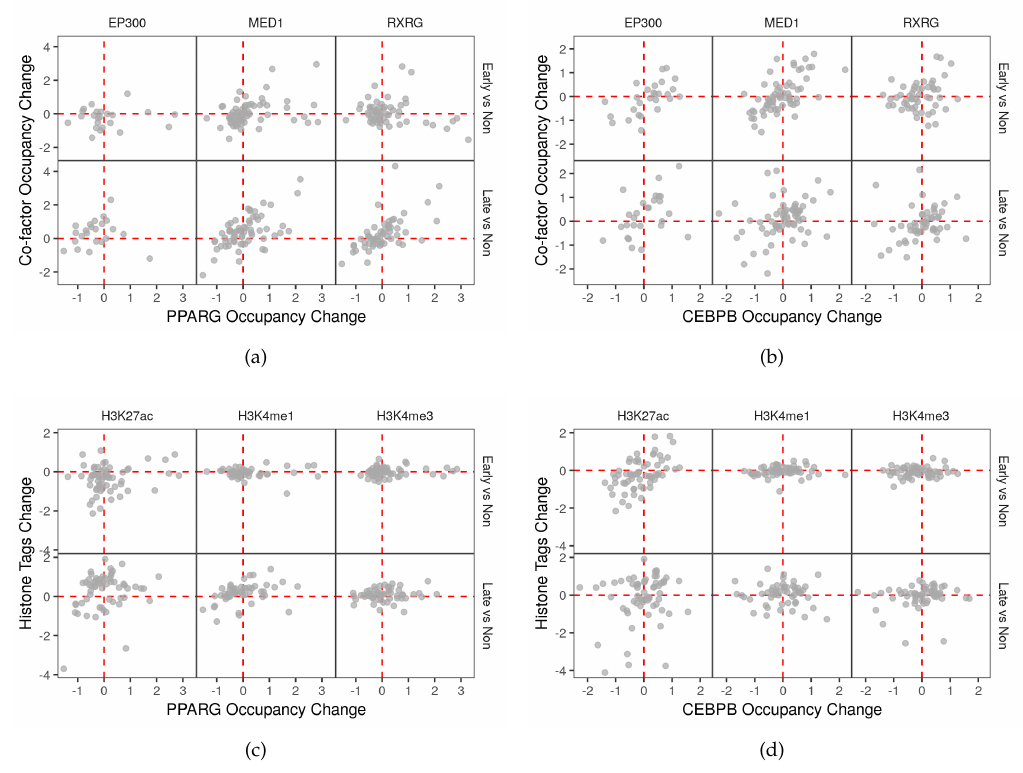
Figure 8. Change in occupancy of transcription factors and co-factors and histone marker tags. The total count of reads in peaks of autophagy genes (n = 158) of ChIP-Seq samples (n = 75) of transcription factors, co-factors and histone modification was used calculate the occupancy. The change in occupancy of ( a , c ) PPARG and ( b , d ) CEBPB in early or late differentiation vs. the non-differentiated samples were plotted against the change in occupancy of co-factors ( a , b ) or histone modification tags ( c , d ). Points represent the fold-change in occupancy between stages of